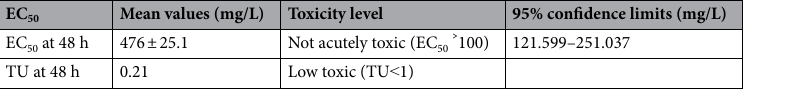
Table 4. EC 50 and TU of PANI/Ag (AMPSA)/GO QDs NC after 48 h of exposure to Artemia salina.